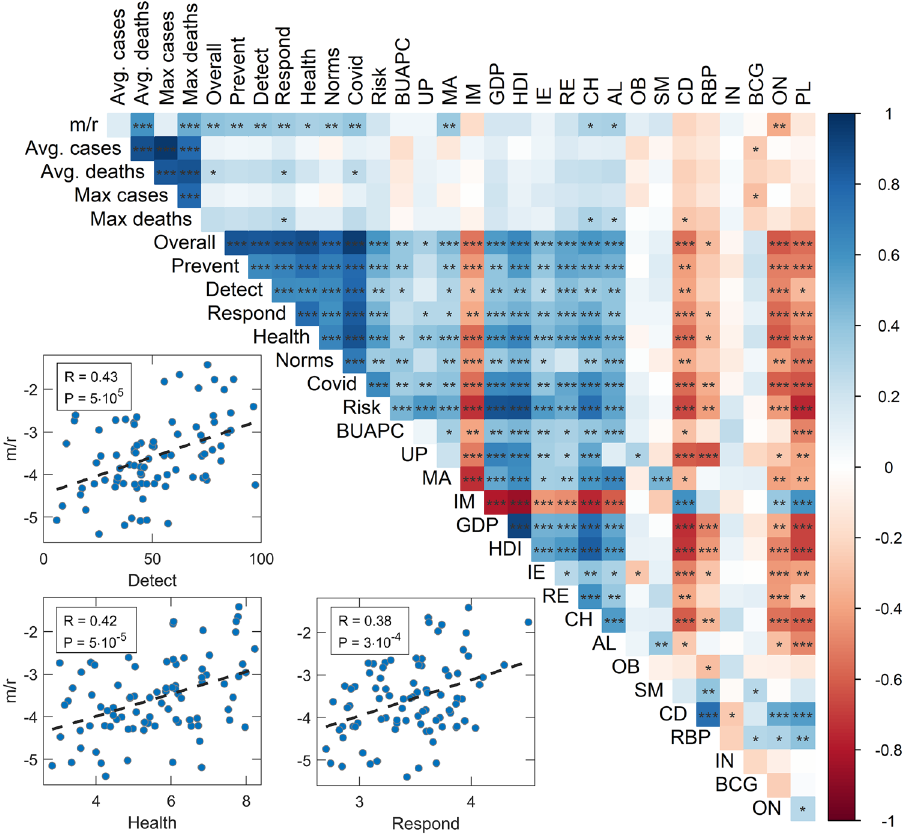
Figure 1. Graphical representation of the predictor correlation matrix (as the matrix is symmetric, only its upper half is shown). Colors correspond to the magnitude of Person correlation coefficients, as indicated by the color bar on the right, while asterisks correspond to the statistical significance of the results (‘ ’ – P > 0.05, ‘ * ’ – 0.05 > P > 0.01, ‘ ** ’ – 0.01 > P > 0.001, ‘ *** ’ – P < 0.001 ). Correlations of m/r and selected three Global Health Security Index categories, relevant for the pandemic, are also represented by scatterplots in the inset. m/r – disease severity measure, Overall – Overall GHSI, Prevent – GHSI Prevent category, Detect – GHSI Detect category, Respond – GHSI Respond category, Health – GHSI Health category, Norms – GHSI Norms category, Risk – GHSI Risk category, Covid – a combination of COVID-related GHSI indicators, BUAPC – built-up area per capita, UP – urban population, MA – median age, IM – infant mortality, GDP – gross domestic product per capita, HDI – human development index, IE – net immigration, RE – refugees, CH – blood